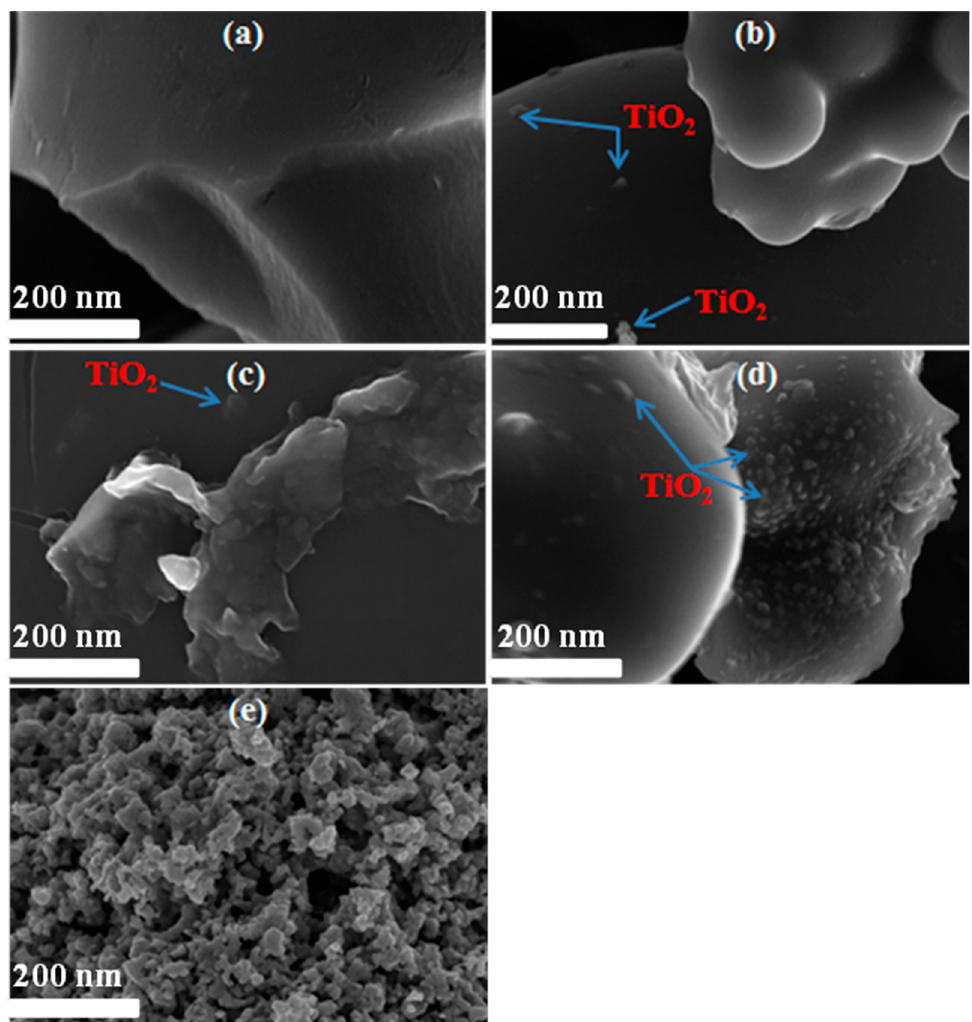
Figure 2. SEM high magnification images of ( a ) C_S solid acid catalyst, ( b ) 1%TiO 2 C_S solid acid catalyst, ( c ) 5%TiO 2 C_S solid acid catalyst, ( d ) 10%TiO 2 C_S solid acid catalyst and ( e ) sulfonated TiO 2 .